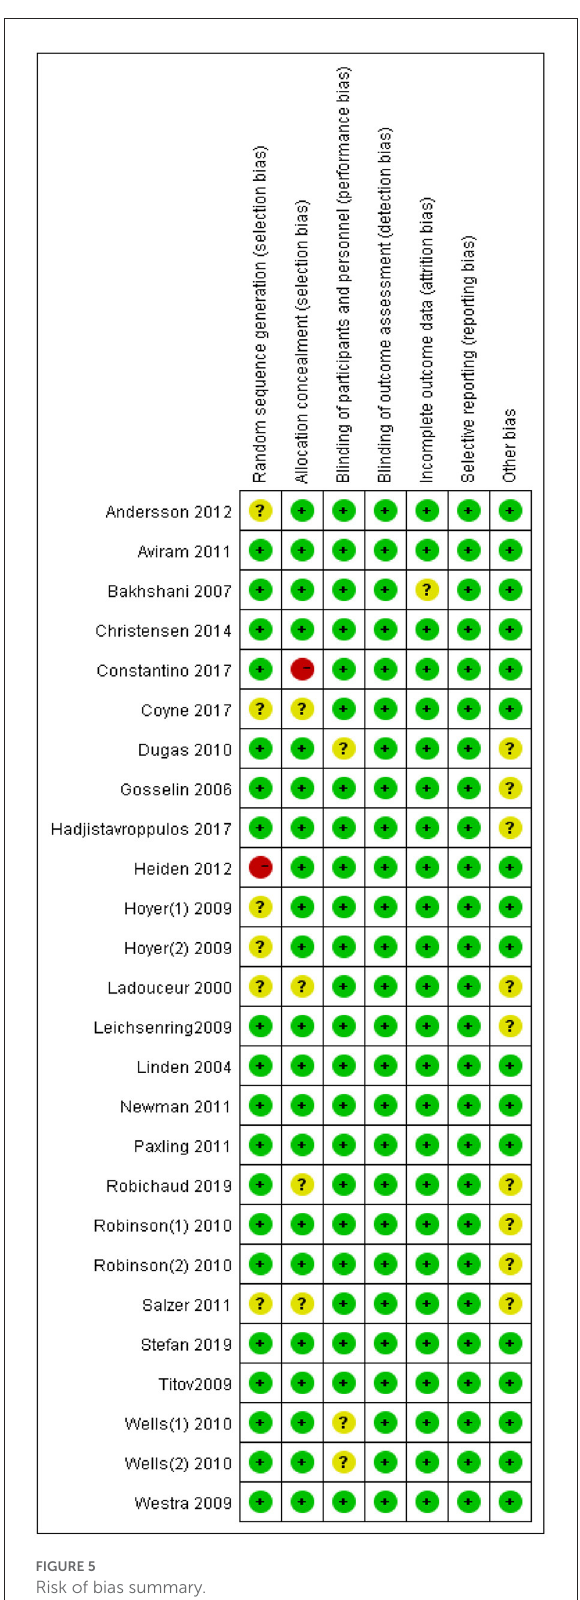
FIGURE5 Risk of bias